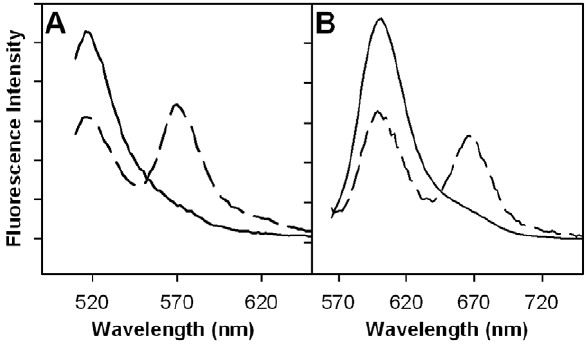
Figure 1. Fluorescence emission spectra of labeled protein reagents exhibit resonance energy transfer. A ) Fluorescence emission spectra of 10 nM PA E733C*AF488 (solid line; donor alone) and 10 nM PA E733C*AF488 + 10 nM CMG2 R40C*AF546 (dashed line; donor + acceptor) in HBST. Both spectra were acquired using 485 nm excitation. B ) 10 nM PA E733C*AF568 (solid line; donor alone) and 10 nM PA E733C*AF568 + 10 nM CMG2 R40C*AF647 (dashed line; donor + acceptor) in HBST. Both spectra were acquired using 556 nm